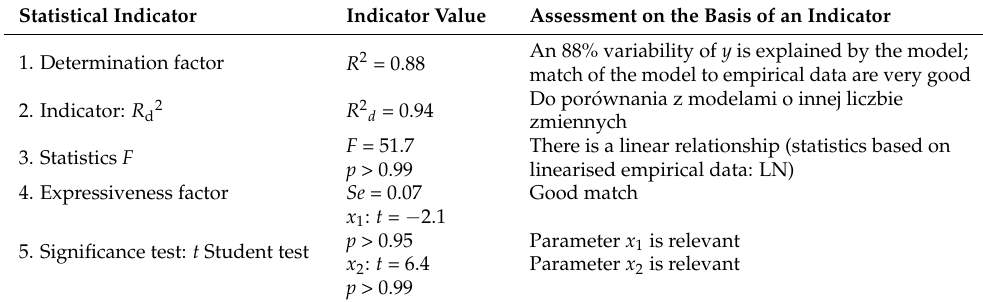
Table 6. Statistical data for the econometric model no. (2).